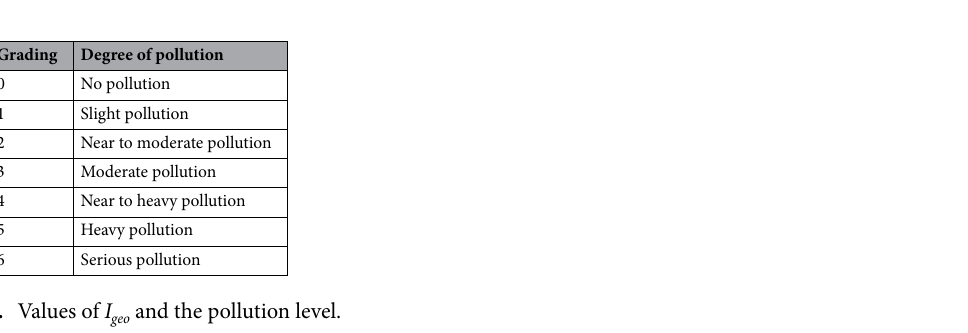
Table 1. Values of I geo and the pollution